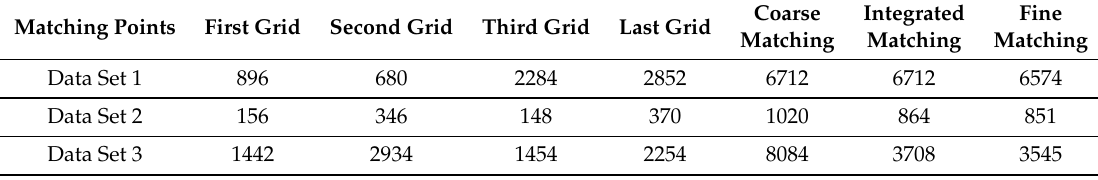
Table 2. Point matching results by different